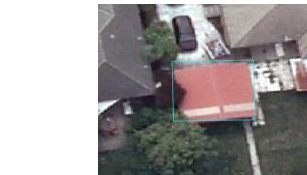
Figure 14. Left: a cut of the change detection result from Figure 7 that corresponds to the surroundings of validation point 1 in Figure 13; right: an aerial photo that covers the region of validation point 1. Figure 17. Left: a cut of the change detection result from Figure 7 that corresponds to the surroundings of validation point 4 in Figure 13; right: an aerial photo that covers the region of validation point 4.